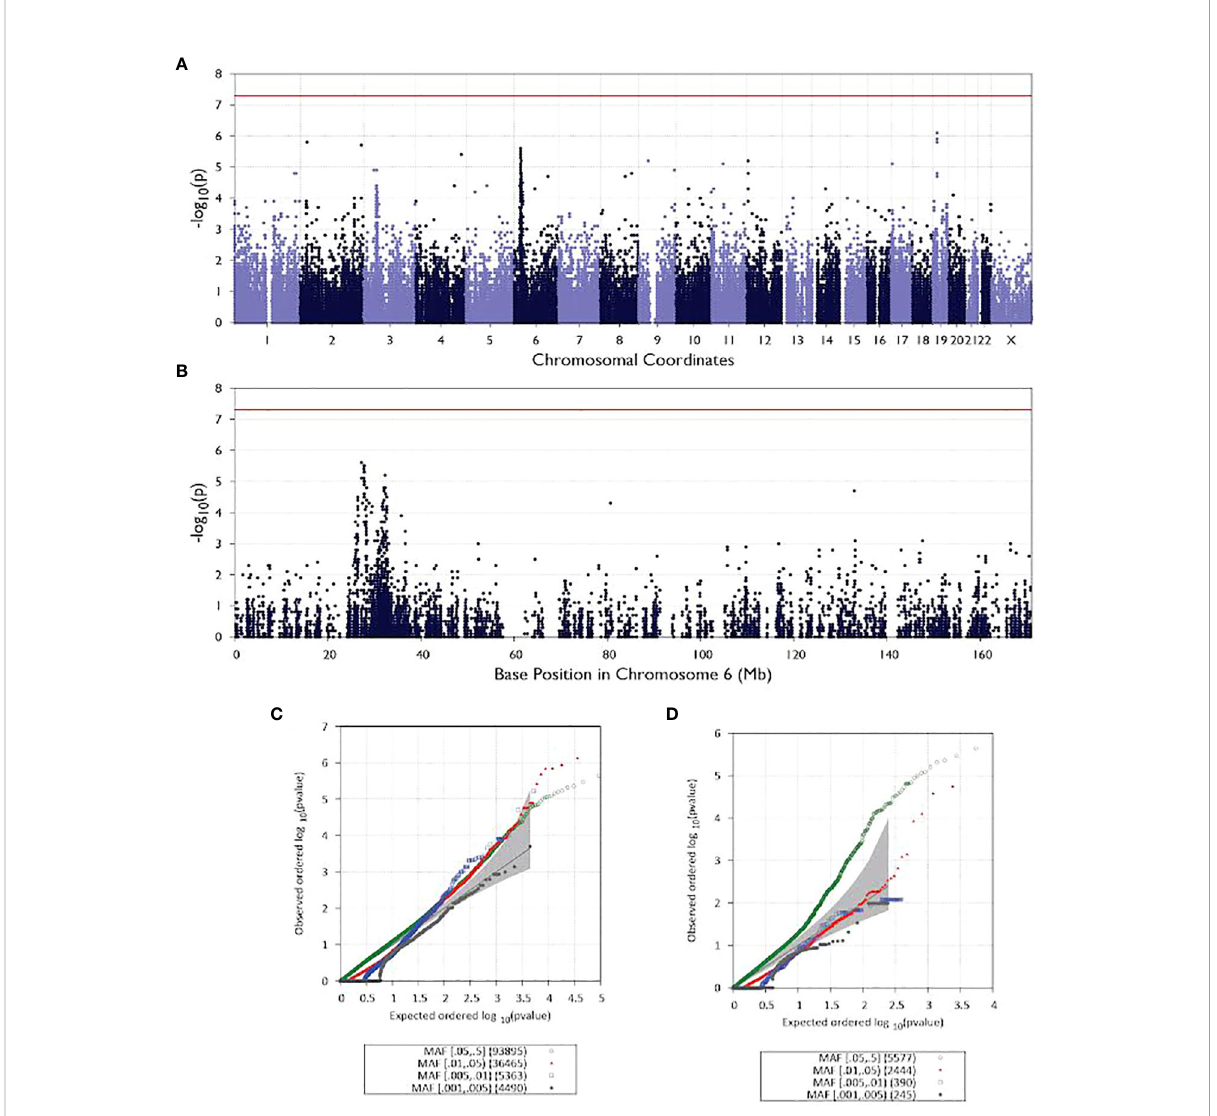
FIGURE 3 Manhattan and QQ plots for all analyzed patients. All chromosomes are illustrated as Manhattan plots in (A) and QQ plots in (C) . Manhattan plot for chromosome 6 in (B) and QQ plots for the same chromosome in (D)